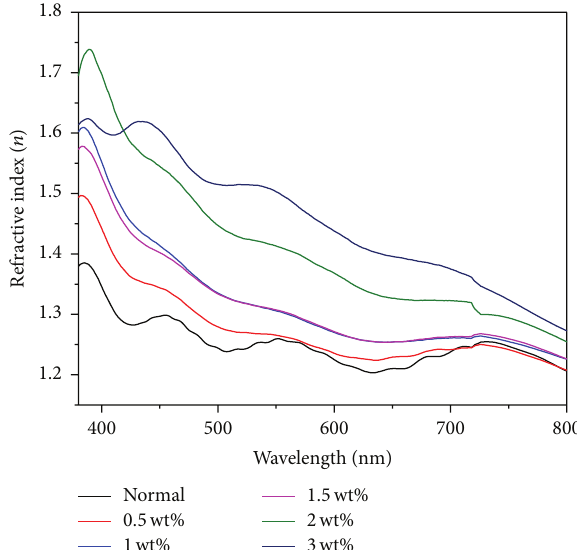
Figure 6: Refractive index of TiO 2 thin films with different wt% of carbon black.